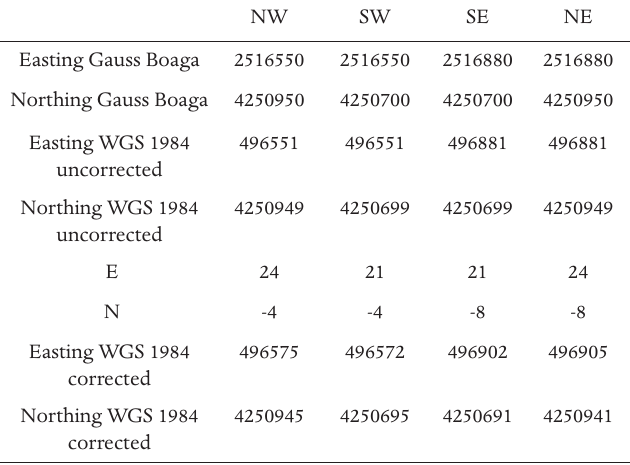
Table 3. Original Gauss Boaga pairs of coordinates for the four quoted corners reported in the maps of Bukumirovic et al. [1997], as uncorrected WGS 1984 converted values, D E and D N calculated with Equations (5) and (6), and corrected WGS 1984 values.